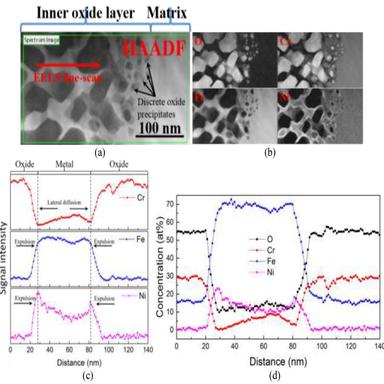
Morphology and chemistry of the two-phase structure in TEM sample 1. (a) HAADF image showing the morphology around the inner oxide layer-metal matrix interface (TEM sample 1); (b) qualitative and EELS chemical composition maps showing the distribution of O, Cr, Fe, and Ni; (c) qualitative and (d) quantitative EELS chemical composition line-scan showing the distribution of O, Cr, Fe, and Ni.